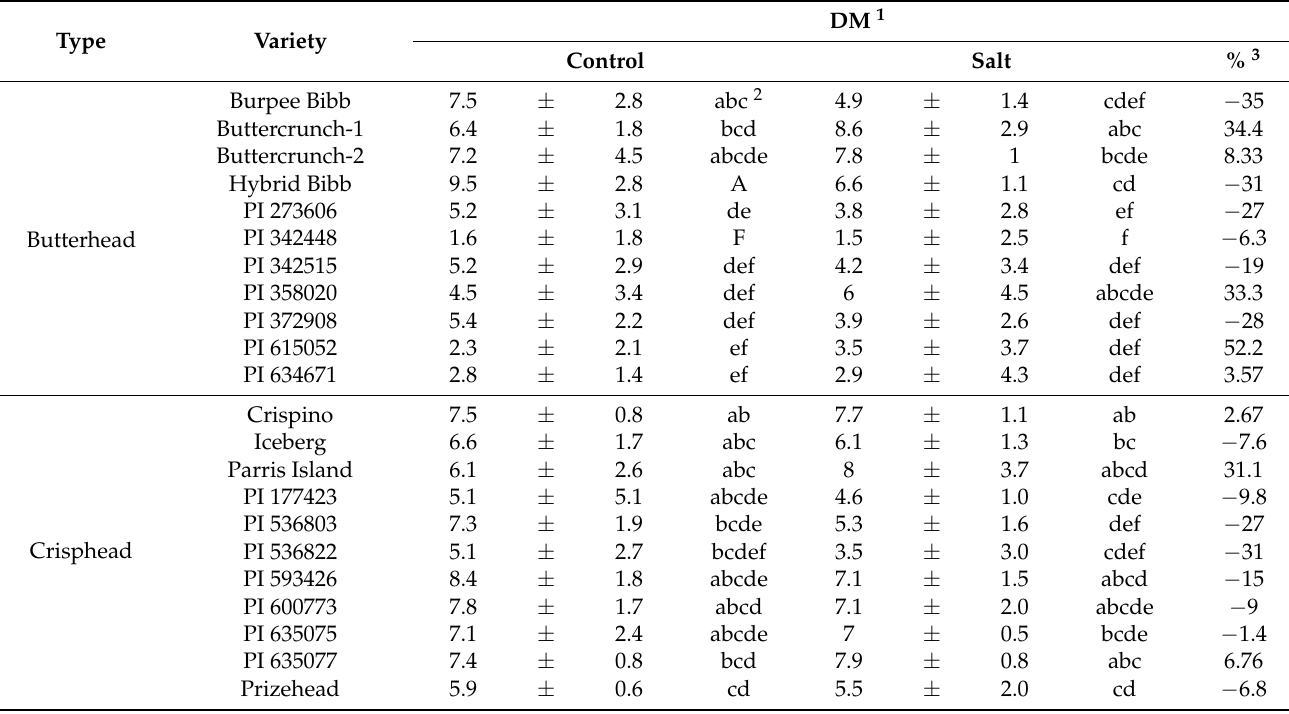
Table 5. Dry mass (DM) (mean ± standard deviation, n = 6) of butterhead- and crisphead-type lettuce cultivars